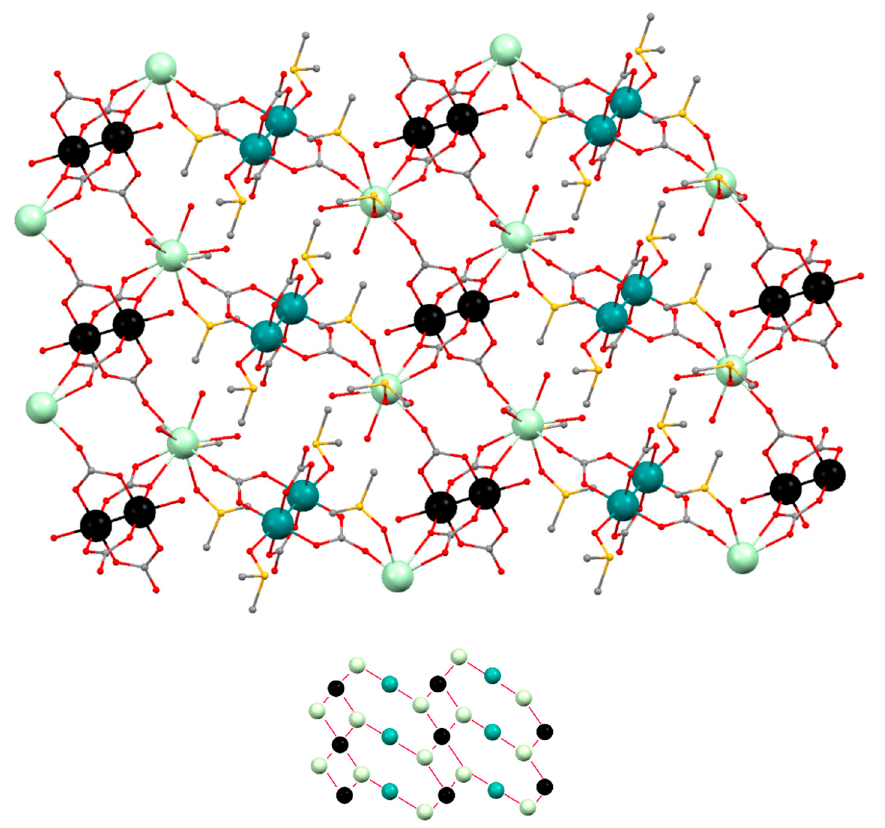
Figure 5. ( Top ): Ball and stick representation of the 2D structure of Pr α . Ruthenium: turquoise and black; praseodymium: pale green; oxygen: red; carbon: gray; sulfur: yellow. Hydrogen atoms are omitted for clarity. ( Bottom ): Simplification of the 2D net. Turquoise: [Ru 2 (CO 3 ) 4 (DMSO) 2 ] 3 − units; black: [Ru 2 (CO 3 ) 4 (OH 2 ) 2 ] 3 − units; pale green: [Pr(DMSO) 2 (OH 2 ) 3 ] 3+ units.